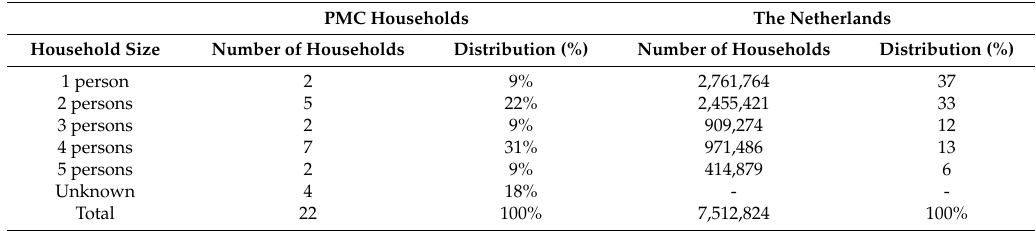
Table 2. Number of residents per household in PowerMatching City (PMC) vs. the Netherlands [adapted from [24]]. PMC Households The Netherlands Household Size Number of Households Distribution (%) Number of Households Distribution